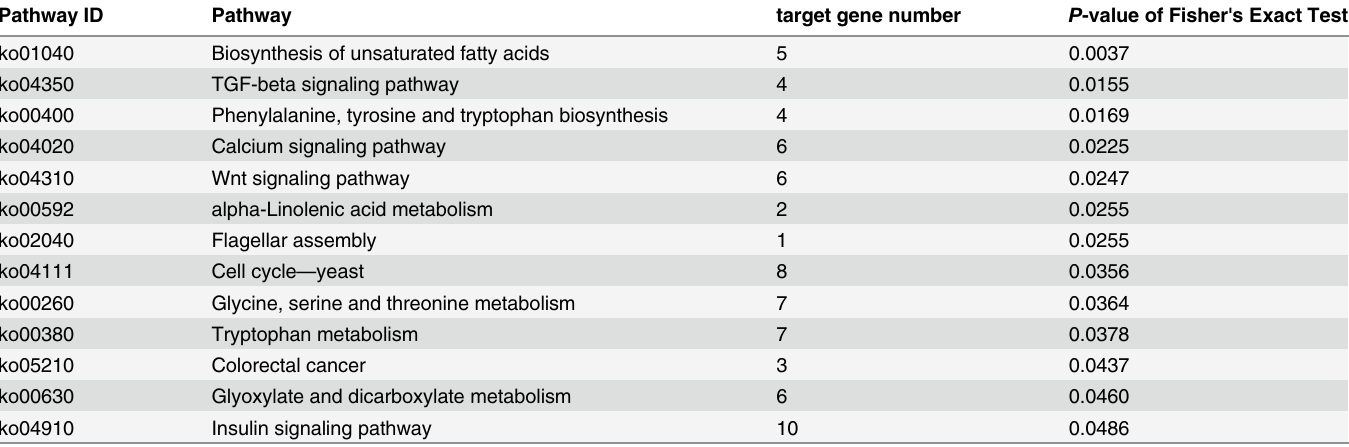
Table 5. The significantly enriched KEGG pathways of target genes for 12 differentially expressed miRNAs. Pathway